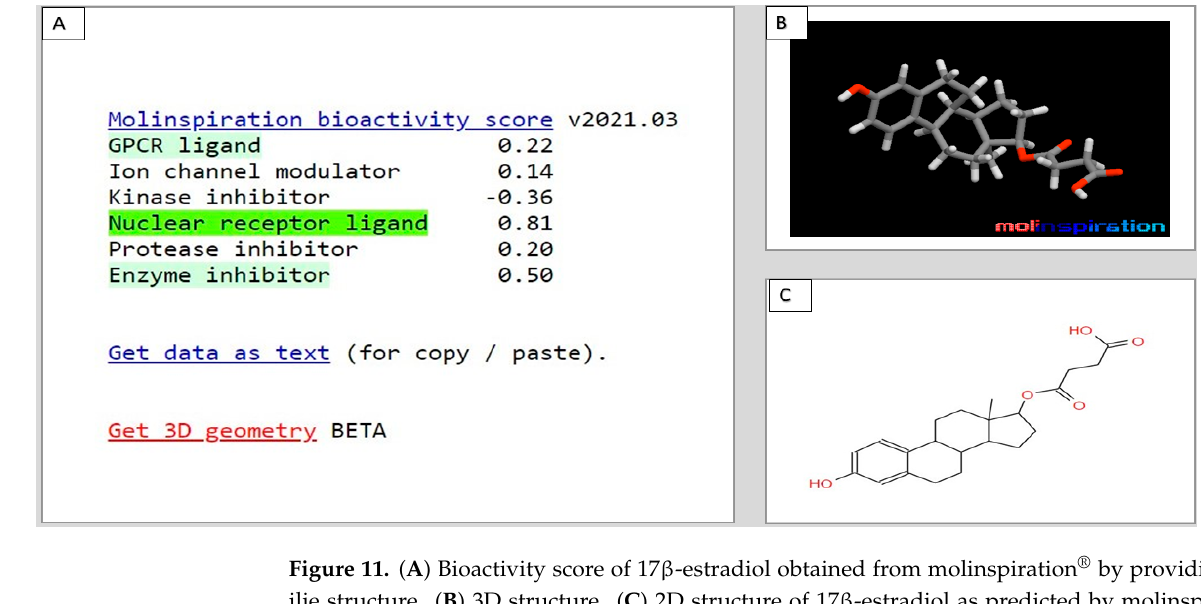
Figure 11. ( A ) Bioactivity score of 17 β -estradiol obtained from molinspiration ® by providing smilie structure. ( B ) 3D structure. ( C ) 2D structure of 17 β -estradiol as predicted by molinspiration web server.